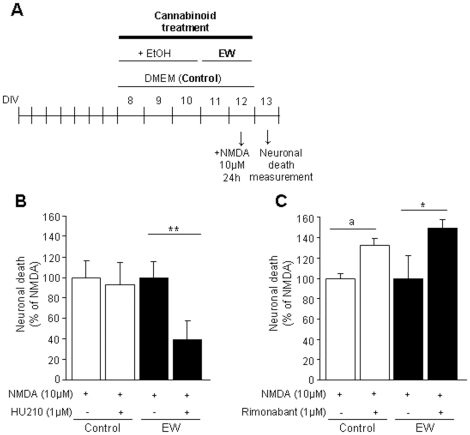
The chronic manipulation of the endocannabinoid system influences neuronal viability during ethanol withdrawal.Effects of the chronic activation or blockade of the endocannabinoid signaling on neuronal viability in control (neurons not exposed to ethanol) or ethanol–withdrawn neurons (EW). (A) Representative scheme of the experimental protocol. (B) The chronic administration of the non-specific cannabinoid agonist HU-210 (1 µM) decreases NMDA-induced neuronal death during ethanol withdrawal. The neuroprotective effect of HU-210 is specific of ethanol withdrawal situation, since it has no effect on the control condition. (C) The chronic administration of the CB1 antagonist rimonabant (1 µM) increases neuronal death. Moreover, the long-term administration of rimonabant tends to be neurotoxic not only for ethanol-withdrawn neurons but also for control neurons. Values are normalized to NMDA and are means ± SEM (n = 6–16 wells/condition; N = 3–4 plates). Data were analyzed by the ANOVA test followed by the Fisher's PLSD test. (*P<0.05; ** P<0.01; a, p = 0.0551).